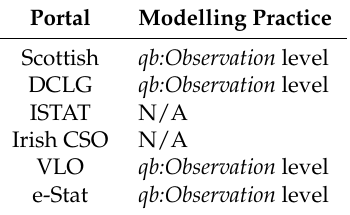
Table 30. Modelling practices of data portals regarding the structural definition of the unit of measure.